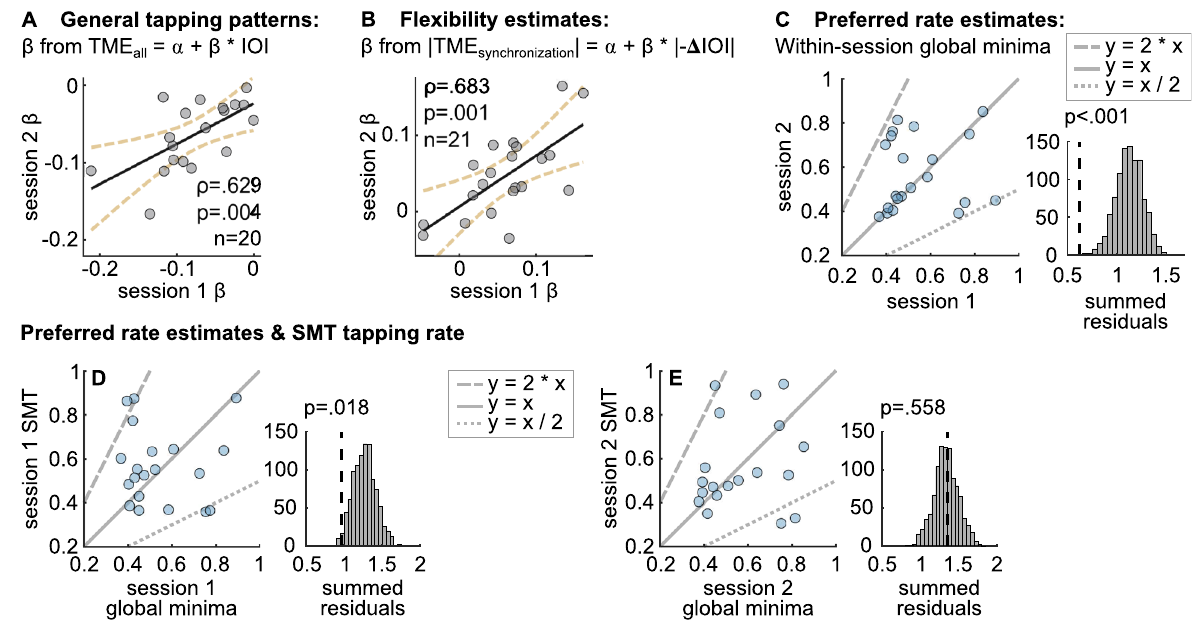
Figure 4. Test–retest reliability of the ( A ) IOI slopes, ( B ) flexibility and ( C ) preferred rate estimates, and ( D,E ) the relationship between preferred rate estimates from the current paradigm and SMT tapping rates. In ( A ) and ( B ), each circle represents a single participant’s β estimates from the equations TME all = a + β × IOI and |TME synchronization |= a + β × |− ΔIOI|, respectively. In ( C ), each circle represents a participants’ within-session global minimum estimate (local minimum of the fitted curves where predicted |TME continuation | was minimum within a single session). Straight line represents 1:1 correspondance, and the dashed lines represent 2:1 and 1:2 ratio between x and y axes. The histogram on the right shows the permutation test results: the distribution of summed residuals (distance of the data points to the closest y = x, y = 2 × x and y = x / 2 lines) with shuffled data over 1000 iterations, and the summed residual from original data (dashed line). On the bottom panel, within- session global minima in ( D ) session 1 and ( E ) session 2 were plotted against the mean SMT tapping rate of the respective sessions. As in ( C ), the histograms show the permutation test results for each